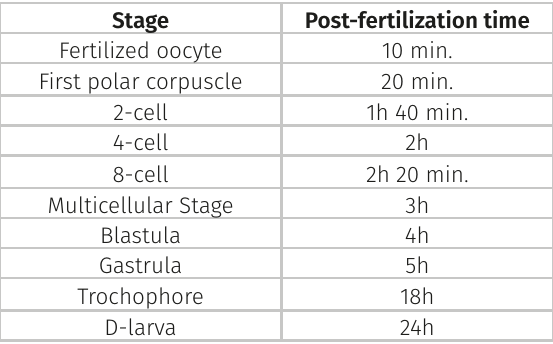
Table I. Embryo stages of Mesodesma mactroides (Reeve, 1854) as a function of time, grown at 25 ± 1 °C (n = 10). Stage Post-fertilization time Fertilized oocyte 10 min. First polar corpuscle 20